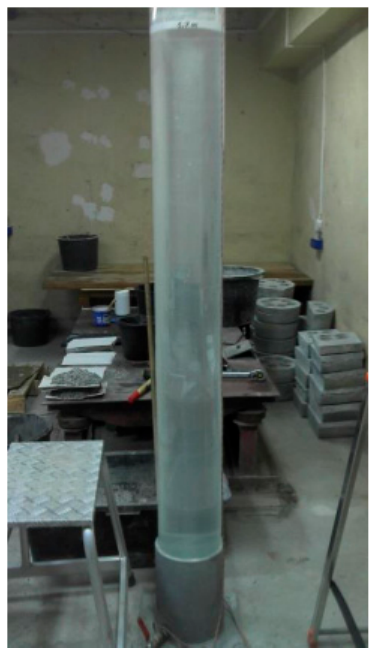
Figure 4. The pipe for wash-out loss testing.